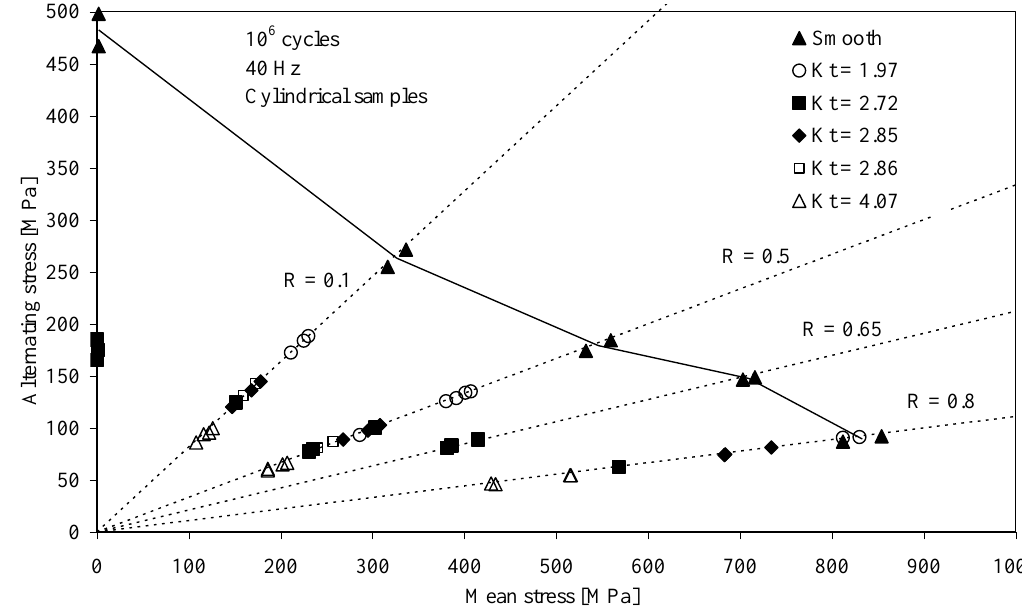
vs. the number of cycles to max